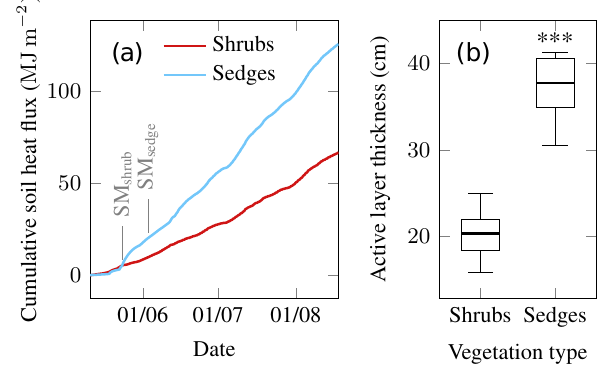
Figure 9. (a) Cumulative soil heat flux 2014 at − 10cm depth, day of complete snowmelt (SM) indicated for dwarf shrubs and wet sedges and (b) spatial variability of active layer thickness within vegetation type, measured 28–30 July 2013, percentiles (25, 50, and 75), minimum and maximum values of eight plots per vegetation type; significant differences between vegetation types are shown with ∗∗∗ ( p ≤